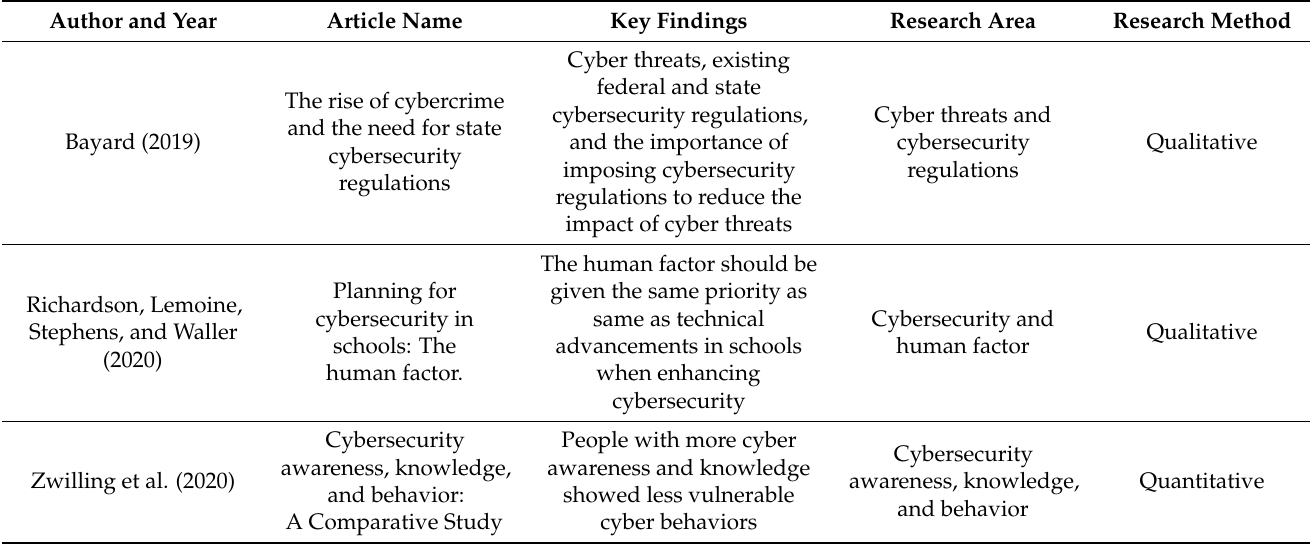
Table A3. Cybersecurity on the